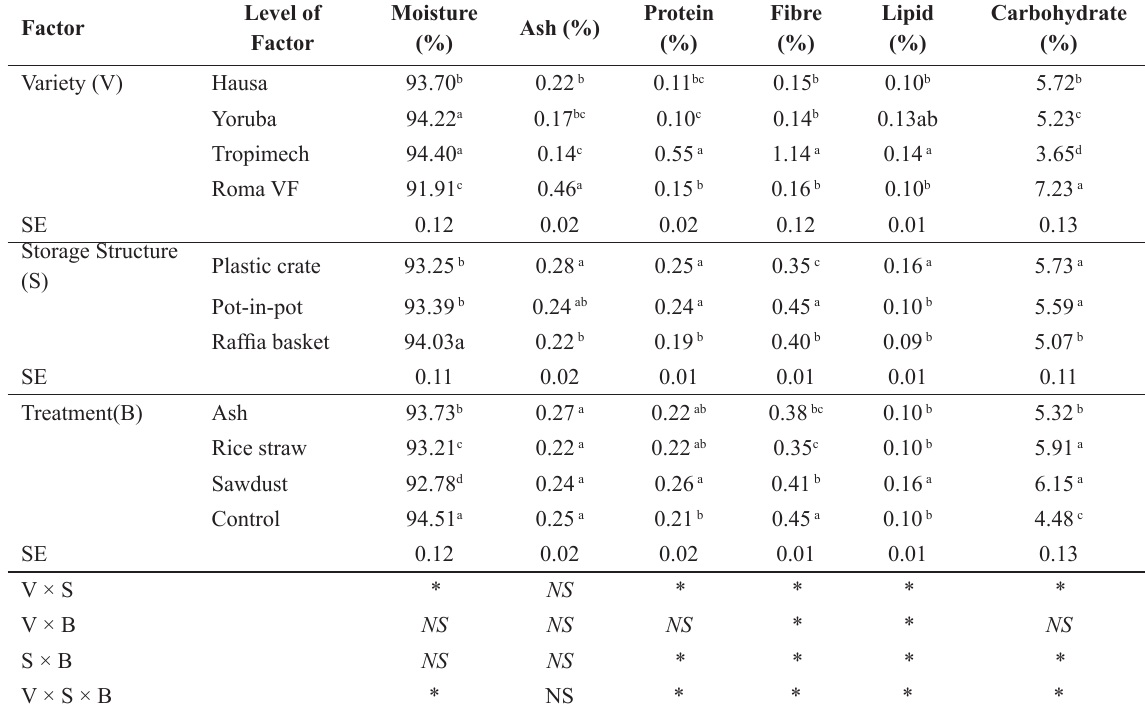
Table 4: Proximate compositions of stored tomato as influenced by variety, storage and botanicals. Level of Factor Variety